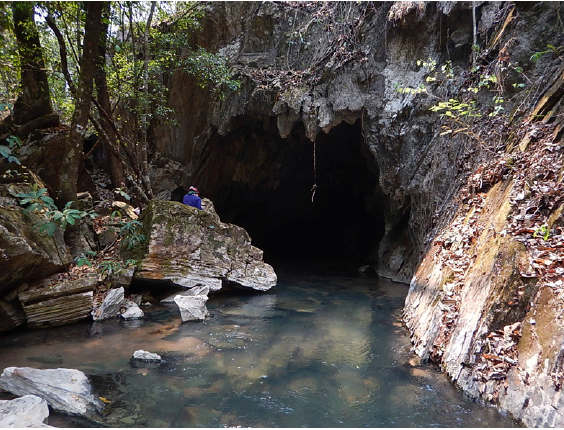
Figure 6. Resurgence outside Duto do Quebó, Nobres, Mato Grosso state, Brazil. Photo by A.